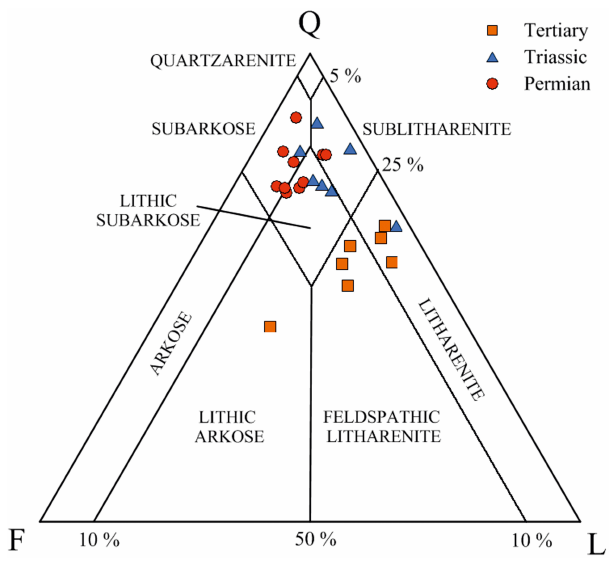
Figure 2. Petrographic sandstone classification after McBride (1963) for samples of this study. This petrographic classification was conducted by identifying and analysing 300 minerals in thin sections of the selected samples and plotting the determined quartz (Q), feldspar (F) and lithoclast (L) content in a ternary diagram. The different colours correspond to the different stratigraphic units and therefore locations (cf. Fig. 1, Table 2).